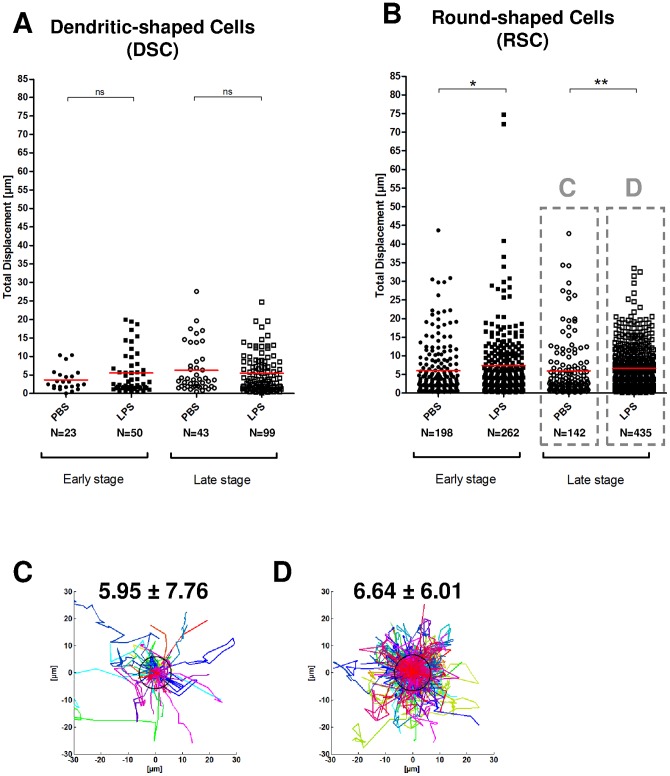
Maximal Distance of CX3CR1-GFP positive pulmonary Dendritic-shaped and Round-shaped cells.A: Dendritic-shaped cells and B: Round-shaped cells at an early stage (average values from 1h30 to 2h30 post injection, closed symbols) and a late stage (average values from 5h to 6h post injection, open symbols) after injection of PBS (rounds) or LPS (squares). Three mice in each group, one symbol by cell. C, D: Overlay of Round-shaped cell tracks after late PBS (C) and LPS injection (D), after aligning their first coordinates. One color by track. Values of black circle radii in µm, equal to average cell Maximal Distance, are indicated ± standard deviation. * for p<0.05; ** for p<0.01; *** for p<0.0001; ns for not significant.